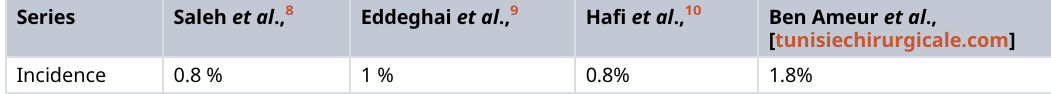
Table 1. Incidence of vascular complications in liver hydatidosis in the